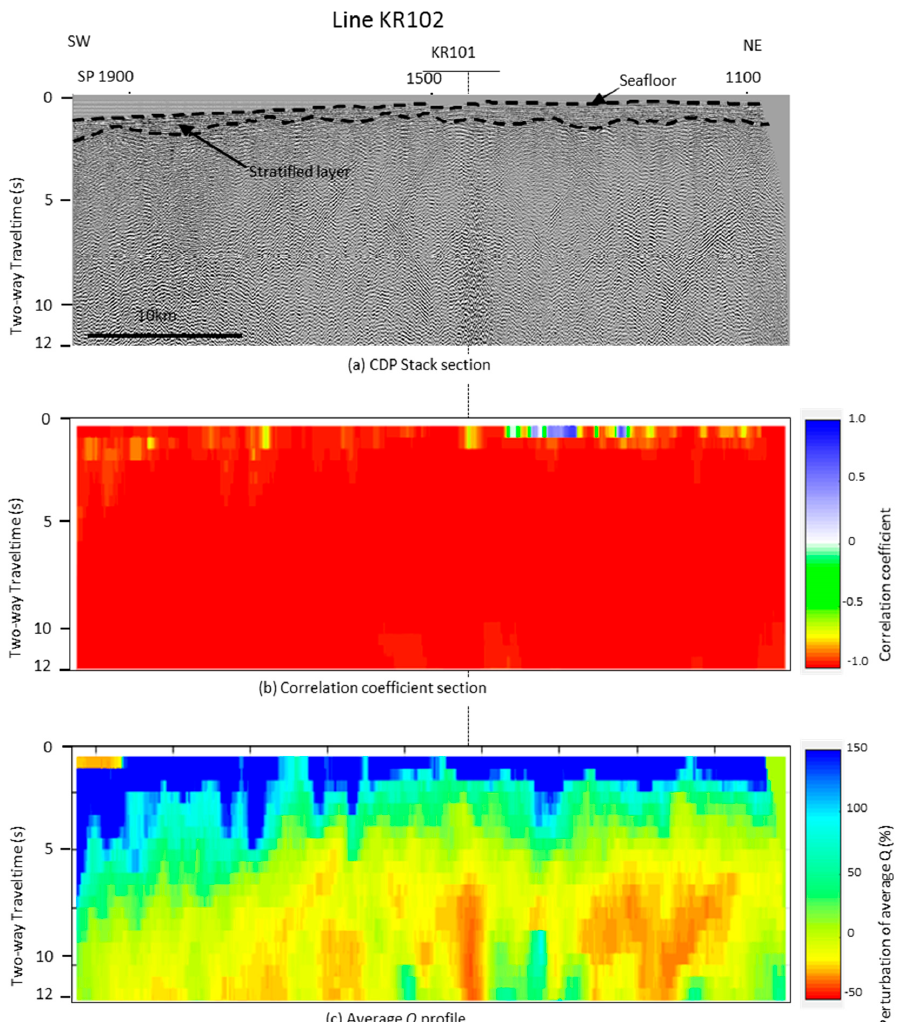
Figure 7. CDP stack section ( a ), correlation coefficient section ( b ), and average Q profile ( c ) of line KR102. The stratified layer with continuous reflections was imaged in the shallowest part on the CDP stack section; however, no reflections can be observed below the layer. The correlation coefficient section shows that almost all of the correlation coefficients in the linear approximation of gradient p represent highly negative correlations (less than − 0.8). A vertical high attenuation anomaly was clearly imaged on the average Q profile near the intersection with